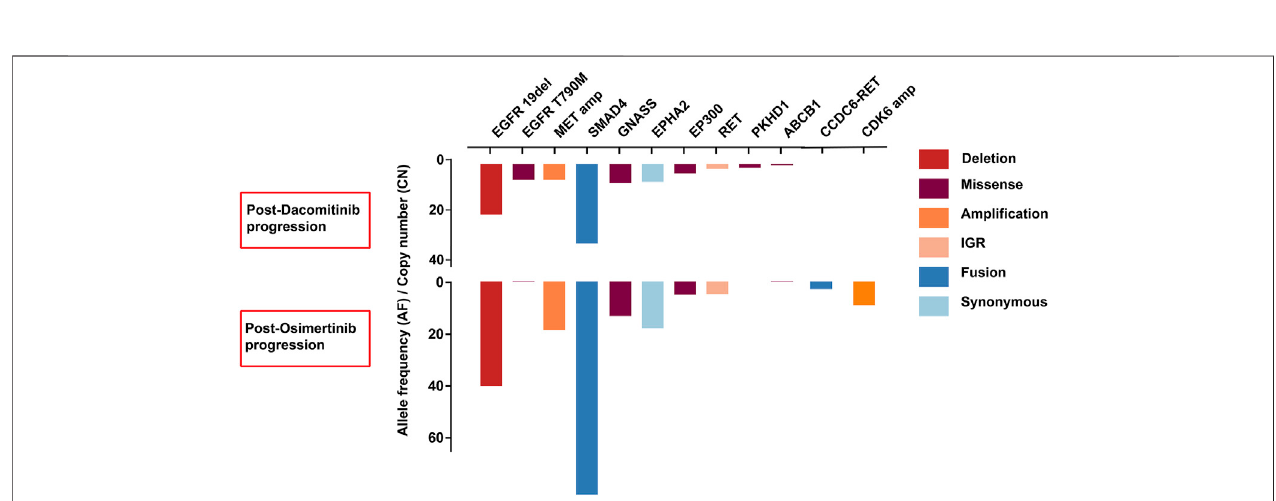
FIGURE 3 | The comparison of resistance mechanisms of genetic alterations between dacomitinib progression and osimertini progression in case 2.